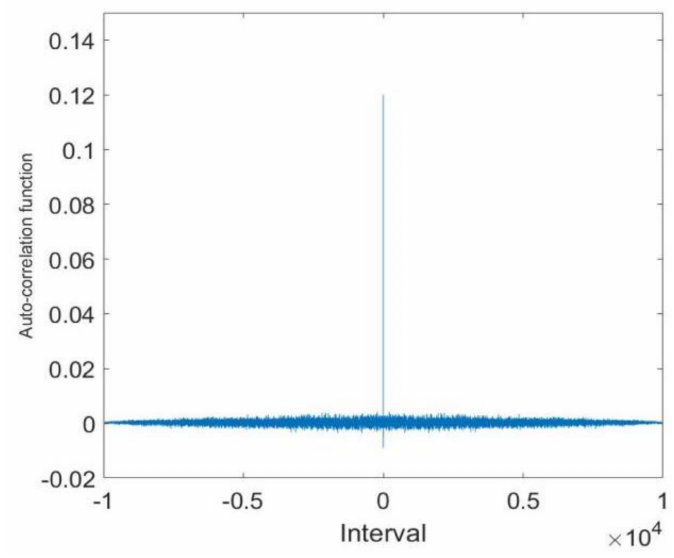
Figure 7. Auto-correlation